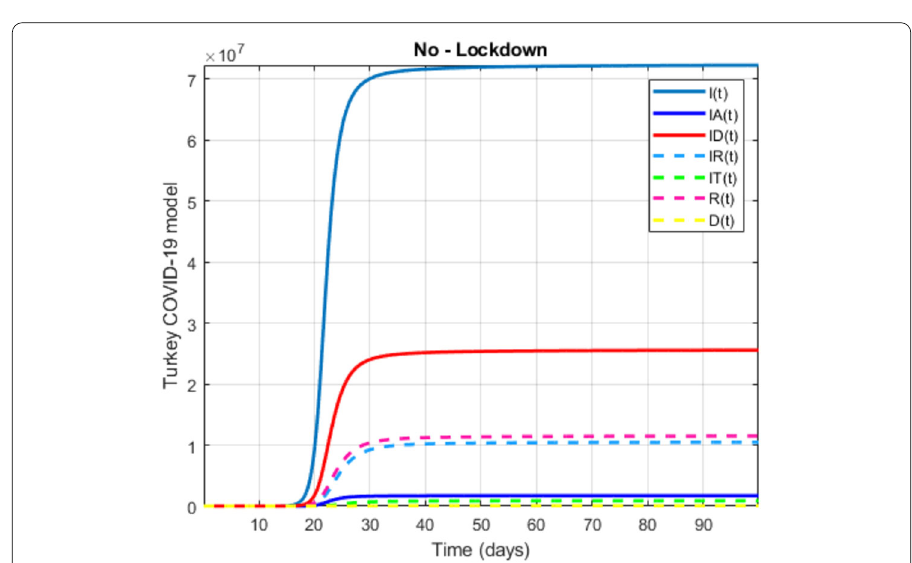
Figure 43 Numerical visualization for Covid-19 model in Turkey for α = 0.9, β =